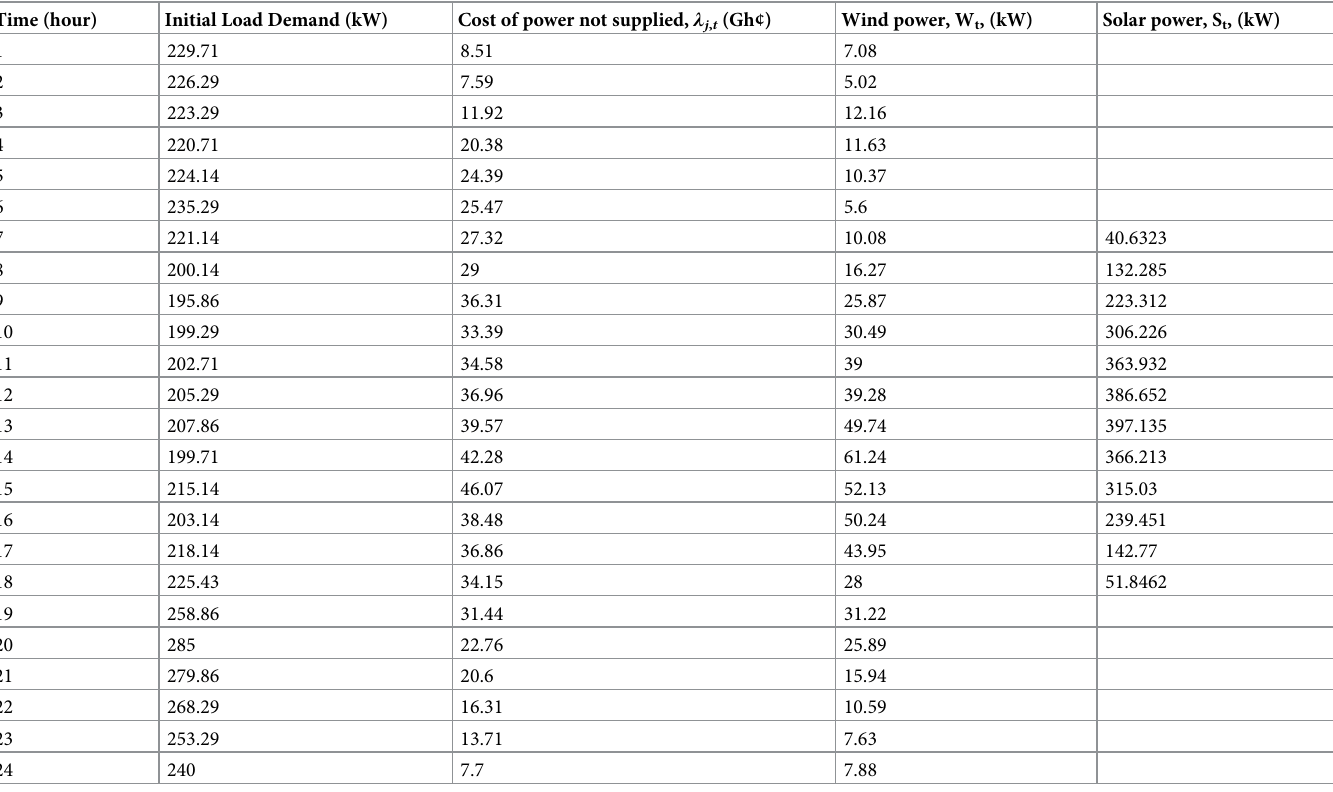
Table 4. Hourly load demand, cost of not supplying power to a consumer, wind power and solar power–case 1. Time (hour) Initial Load Demand